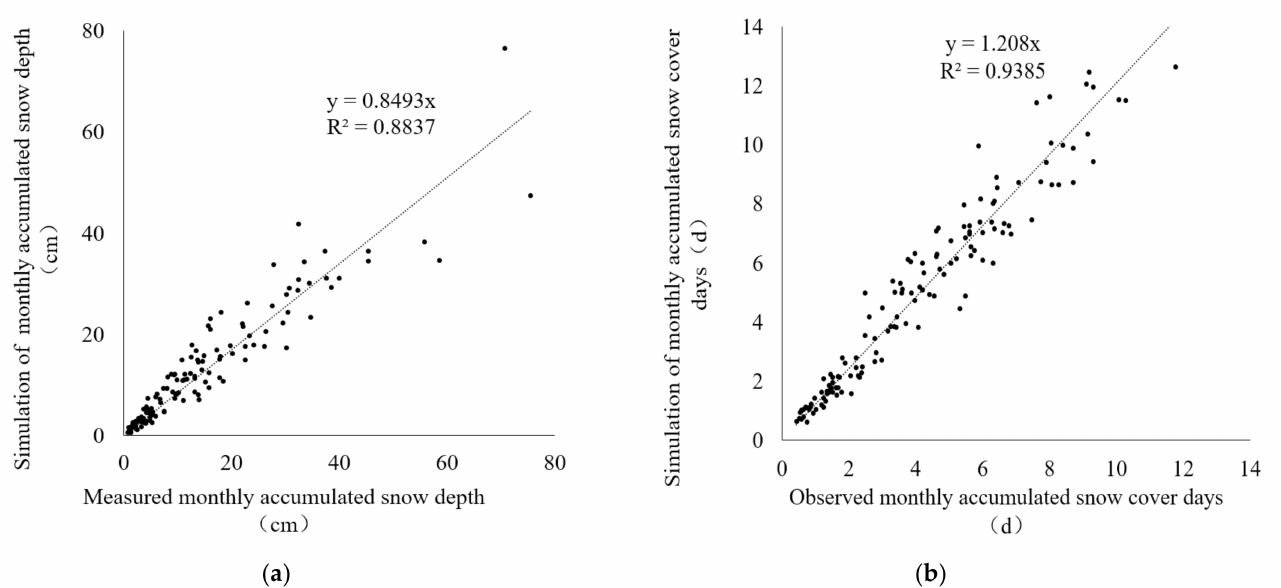
Figure 8. Correlation between simulated and observed monthly values on monthly for ( a ) cumulative snow depth, and ( b ) cumulative snow cover